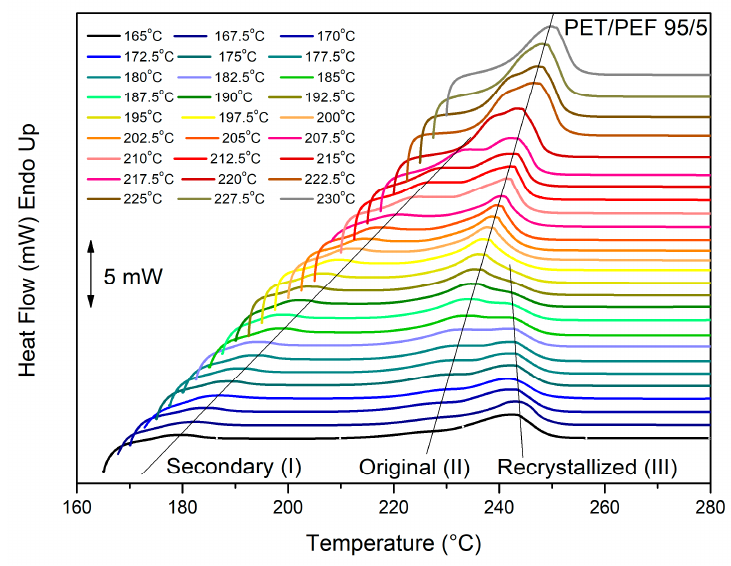
Figure 5. DSC heating scans at 20 °C/min for PET-PEF 95-5 blend samples after crystallization at the indicated temperature.